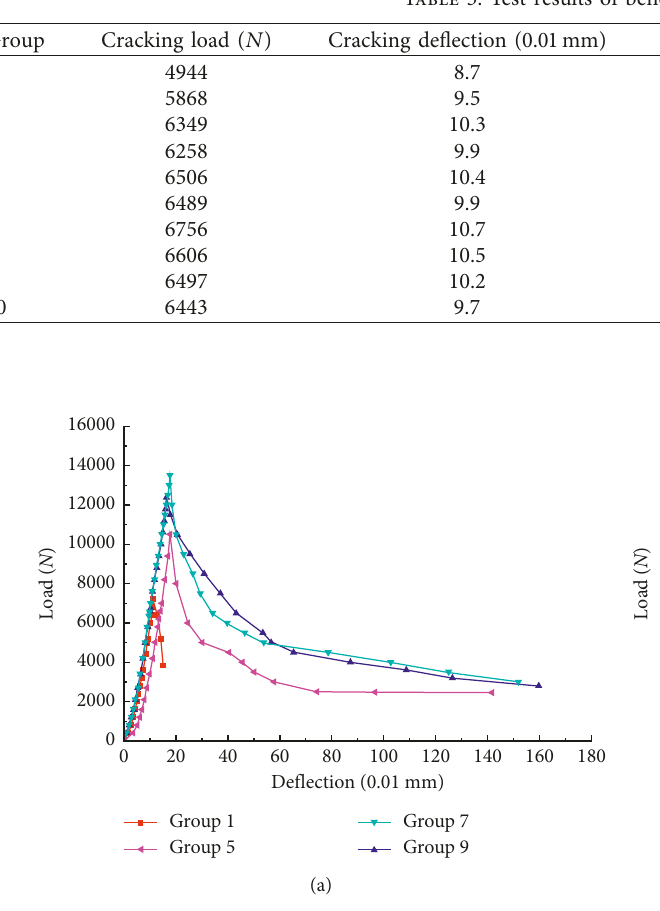
Figure 6: Shotcrete load-deflection curve. (a) Comparison of shear undaform steel fiber concrete and reference concrete. (b) Comparison of shear undaform steel fiber concrete and silica fume